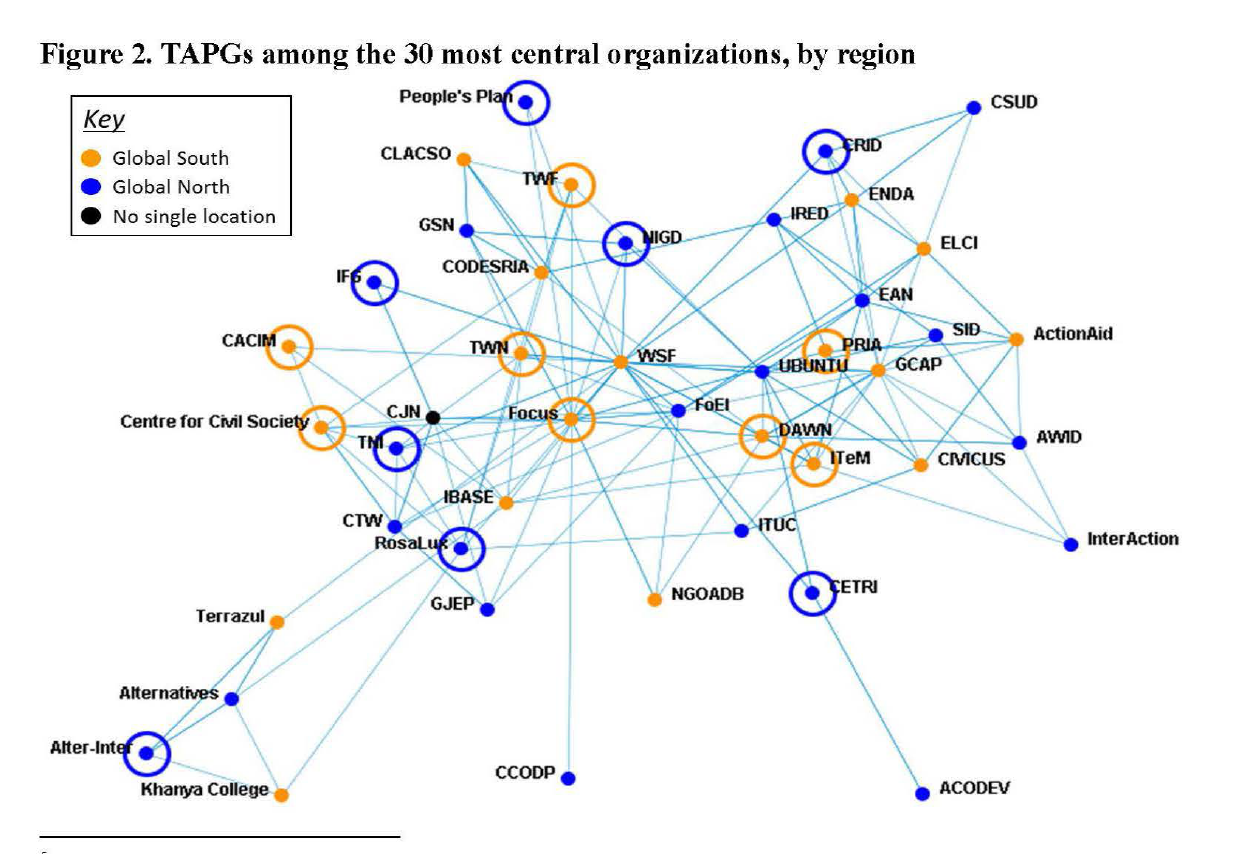
Figure 2. TAPGs among the 30 most central organizations, by